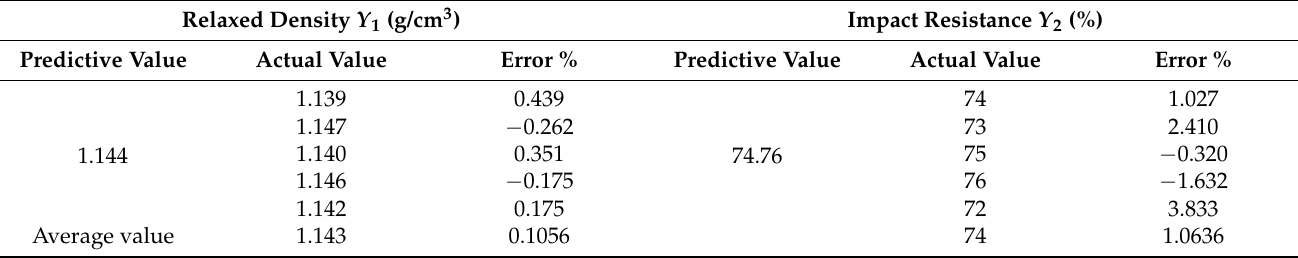
Table 8. Relaxed density and crush resistance of briquettes based on optimal process